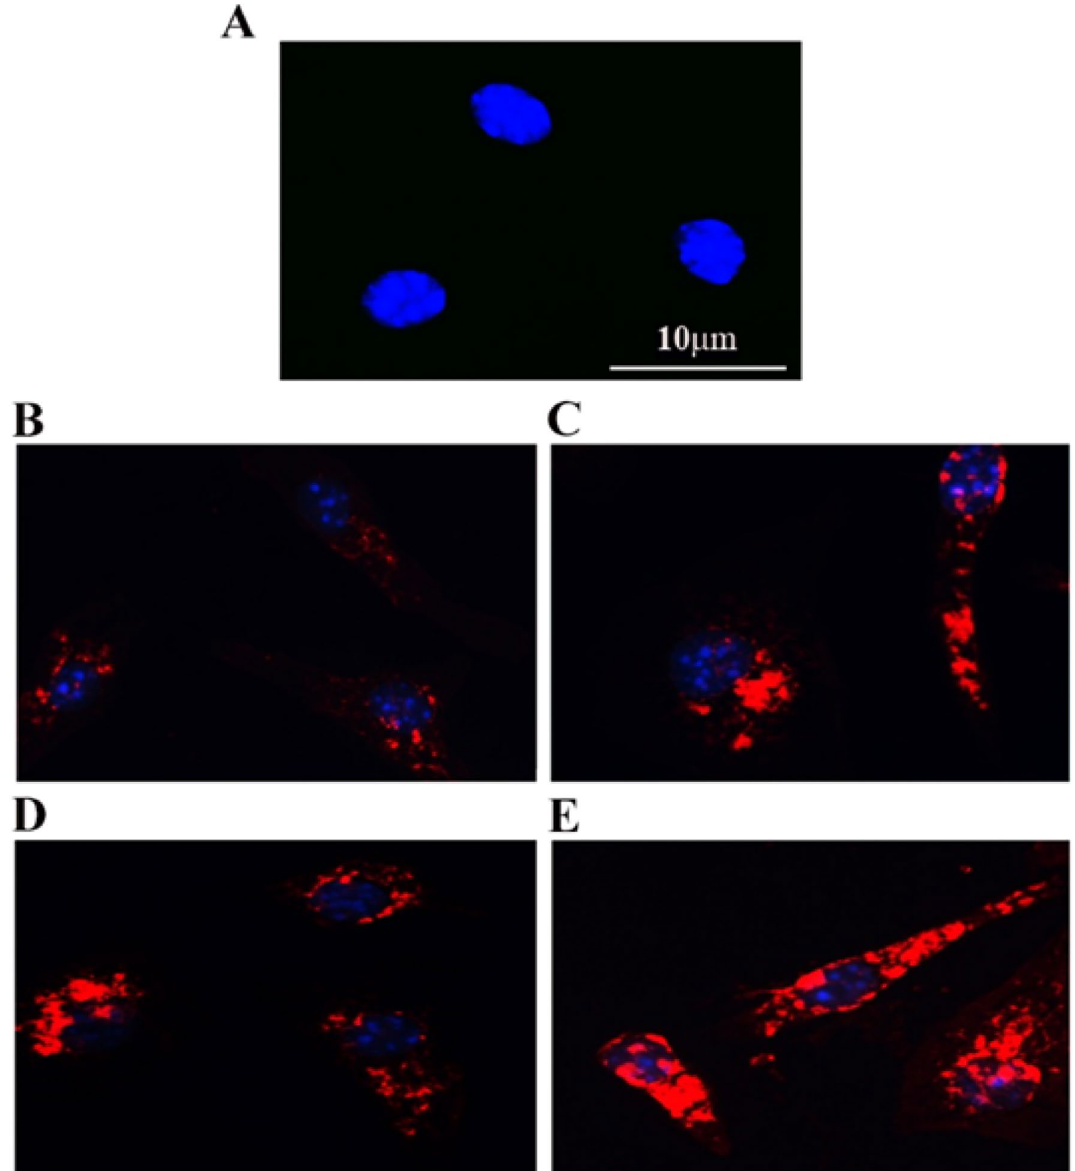
Figure 8. The prepared NPs improved the phagocytosis of pHrodo E. coli bioparticles. ( A ) Untreated control BMDMs stained with DAPI (blue). ( B ) BMDMs treated with pHrodo E. coli bioparticles (red). ( C ) Cells pre- treated with 10 µg/ml functionalized SWCNTs followed by treatment with pHrodo E. coli bioparticles. ( D ) Cells pre-treated with 10 µg/ml ZnO-Ag- followed by treatment with pHrodo E. coli bioparticles. ( E ) Cells were pre- treated with 10 µg/ml ZnO–Au-SWCNTs followed by treatment with pHrodo E. coli